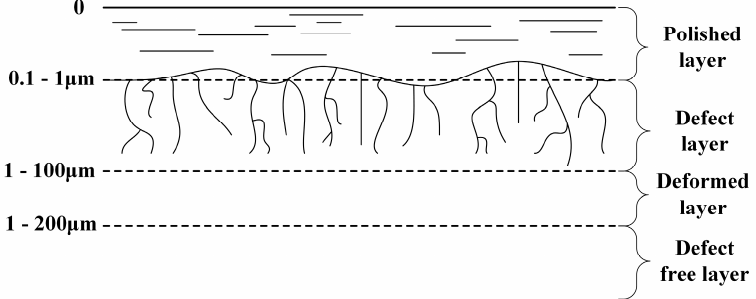
Figure 1. Schematic diagram of subsurface damage (SSD).